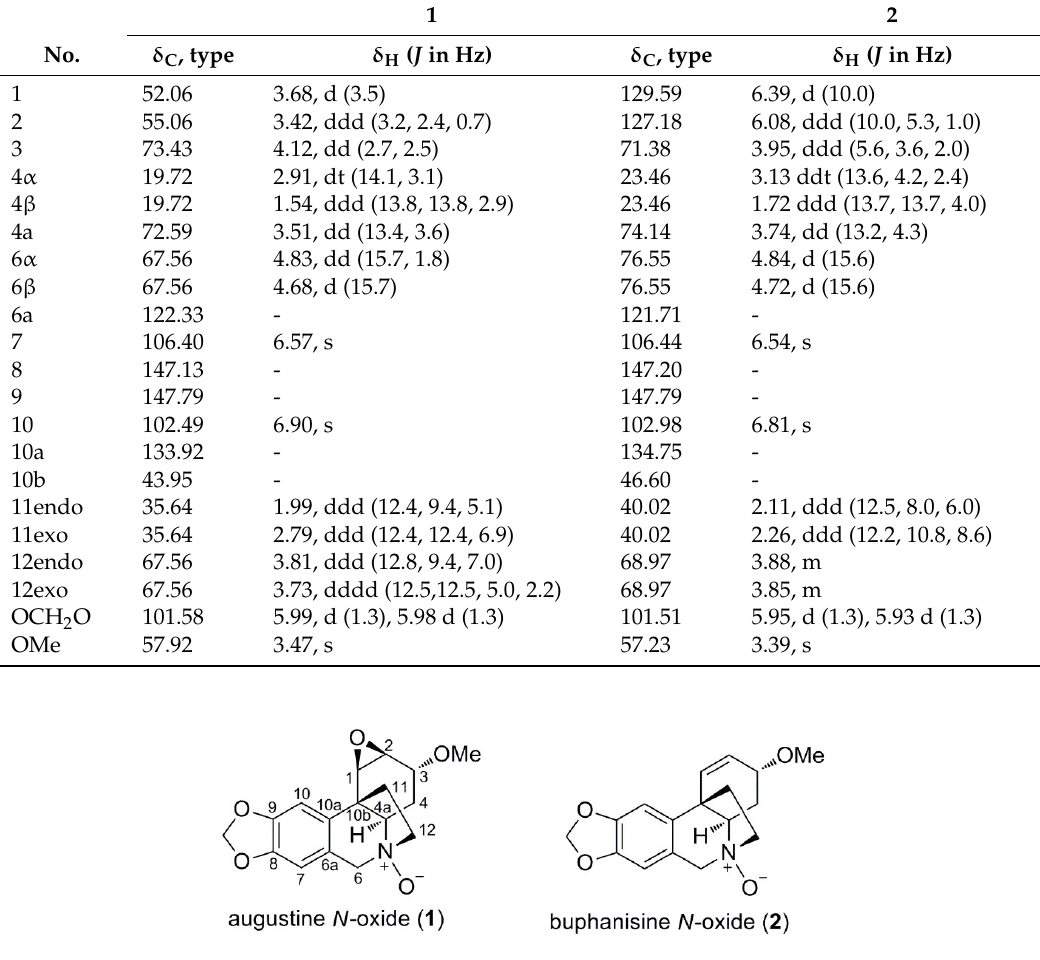
Table 2. NMR data for compounds 1 and 2 (400 MHz for 1 H and 100 Hz for 13 C, CDCl 3 ).